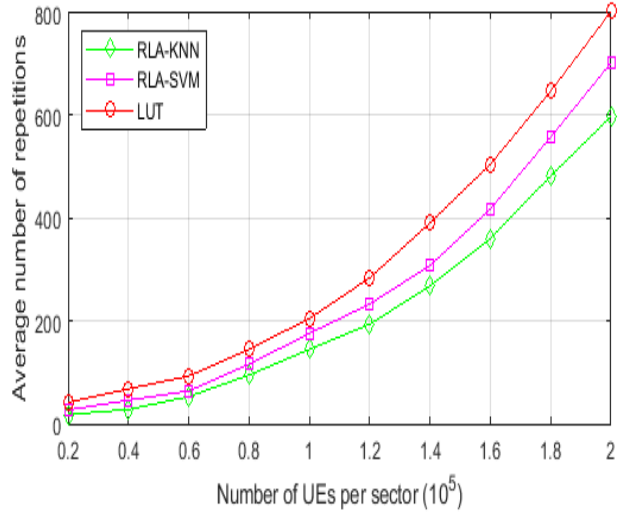
Figure 9. Average number of repetitions.